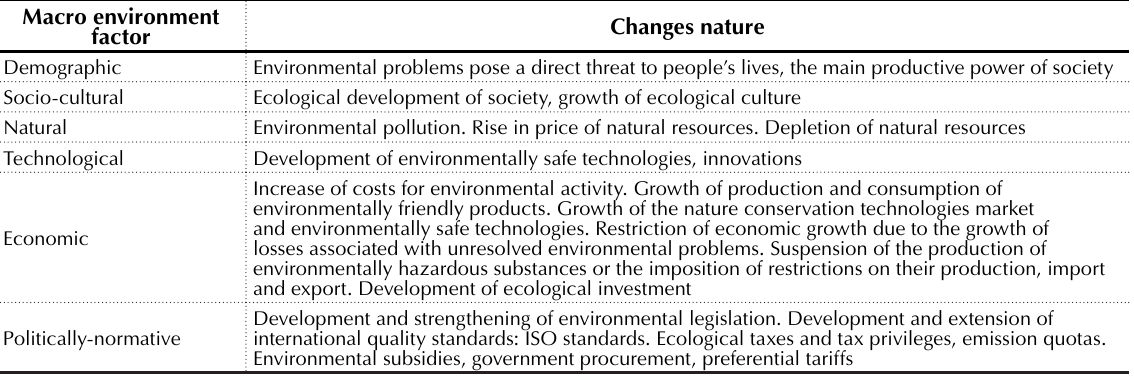
Table 1. Changes in the market player macro-environment under the influence of environmental